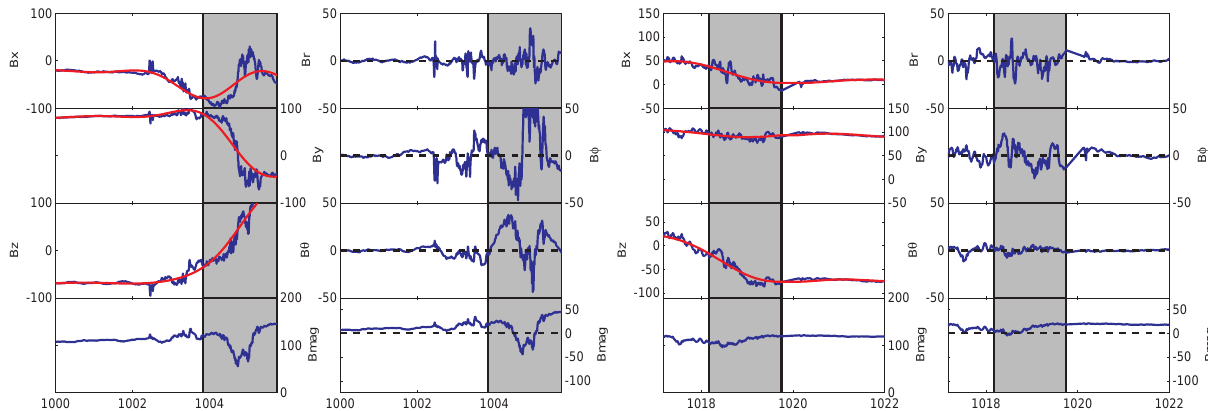
Fig. 7. Left: G28 inbound magnetopause crossing in GphiO coordinates (with the data in blue and the low-pass filtered data in red super- posed) and in mean field aligned coordinates. The grey shaded area is the magnetopause crossing. Right: the same for the G28 outbound magnetopause crossing.